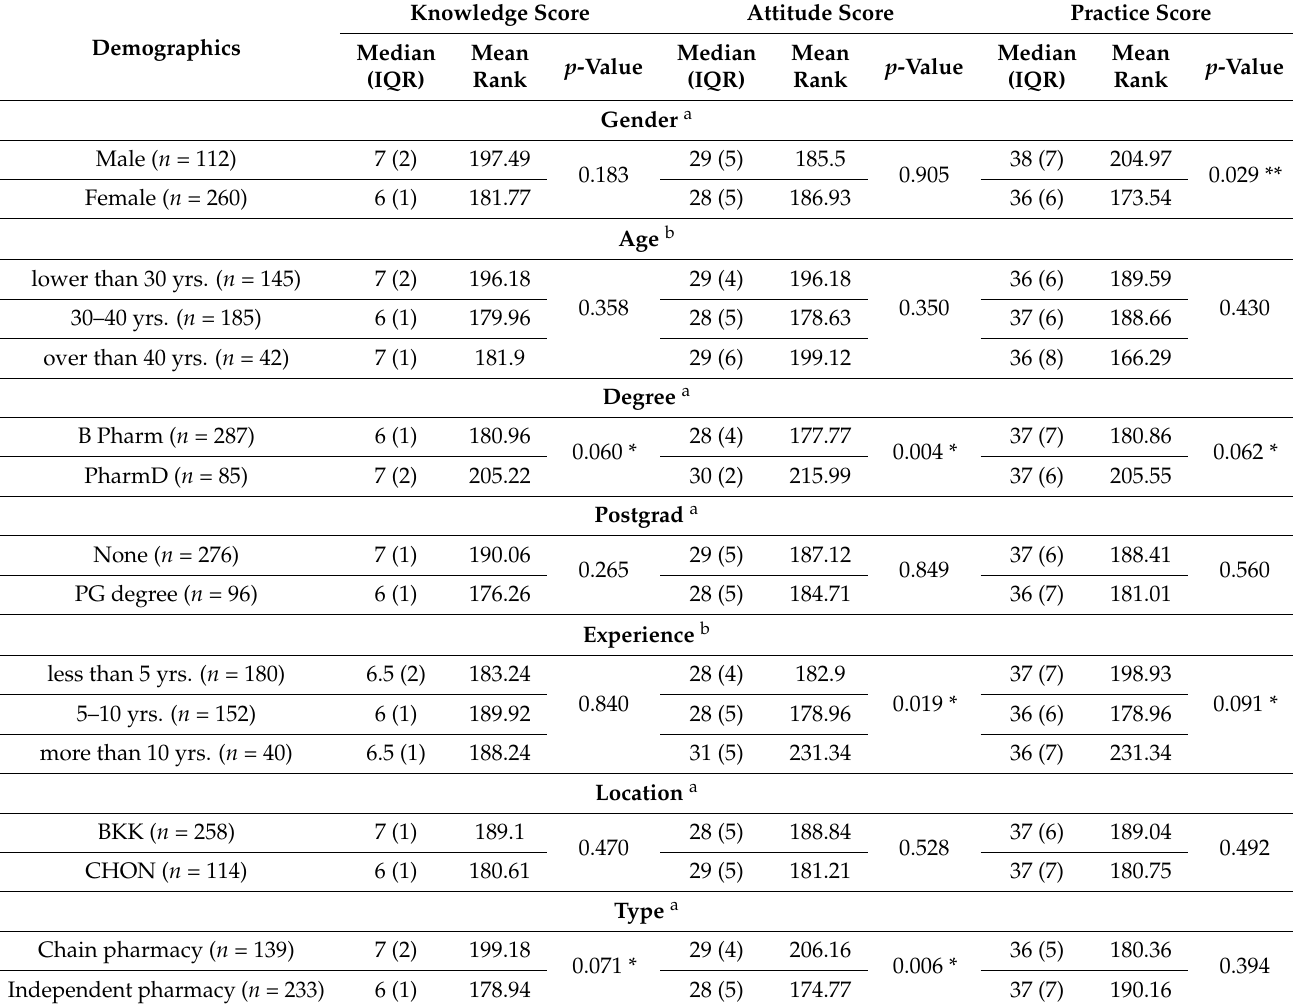
Table 6. The relationship of KAP scores with the community pharmacists’